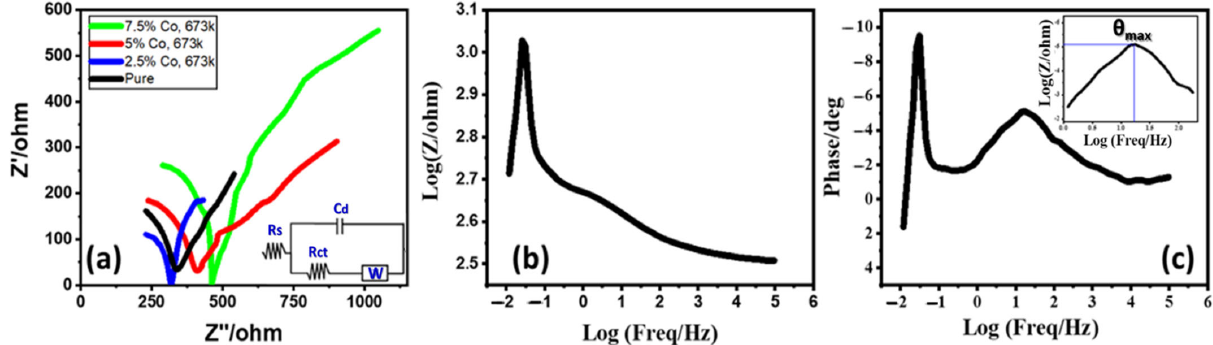
Figure 9. ( a ) Nyquist plots for undoped and doped photoelectrodes in 0.5M NaOH electrolyte at 298 K and 0 V (vs. Ag/AgCl) and under white light illumination. Bode plots ( b ) the change of the overall impedance versus frequency and ( c ) the change of phase versus frequency. Table 3. Comparison of the values of J ph , IPCE%, and ABPE% for the current work with previously studied values for different SnO 2 -based